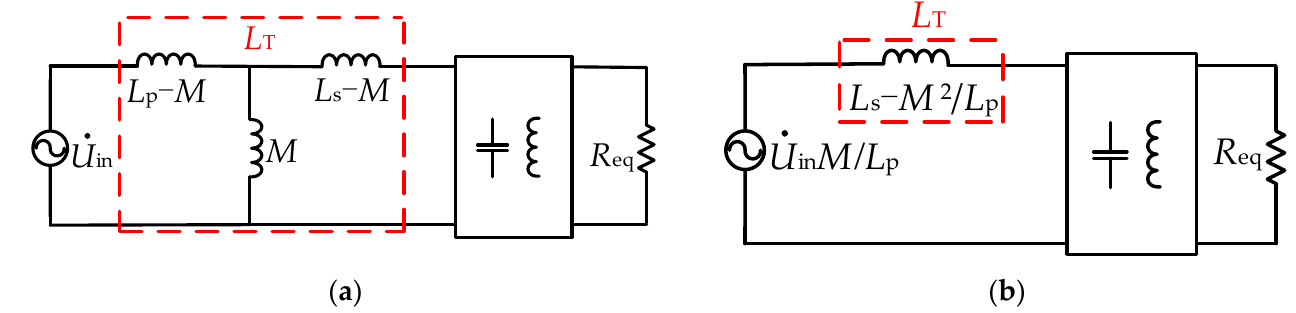
Figure 3. Analysis of equivalent circuit. ( a ) Equivalent circuit model; ( b ) simplified circuit model.